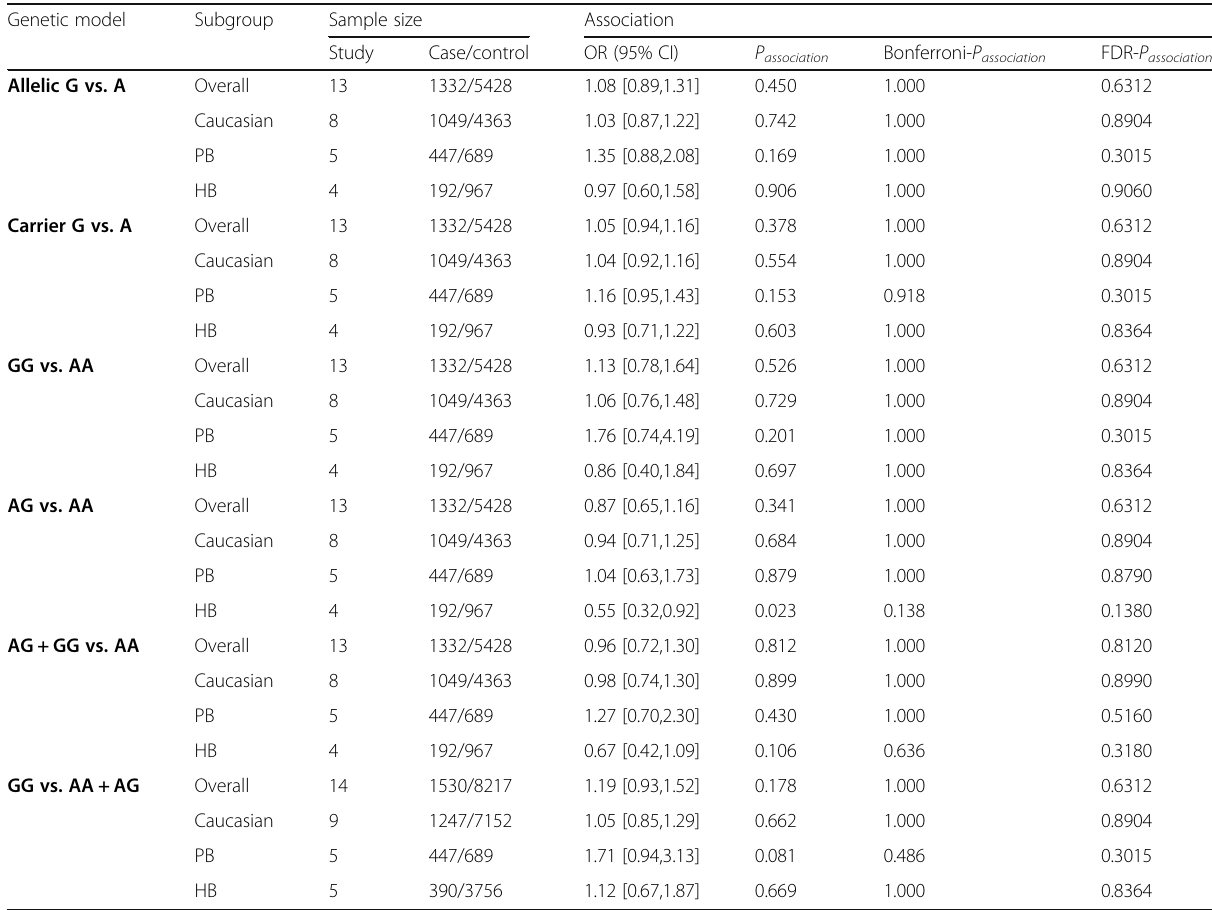
Table 3 Pooling data regarding the association between FCGR2A rs1801274 and pneumonia risk Genetic